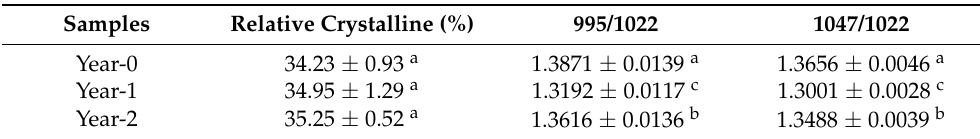
Table 2. Order degree of rice starch from different storage